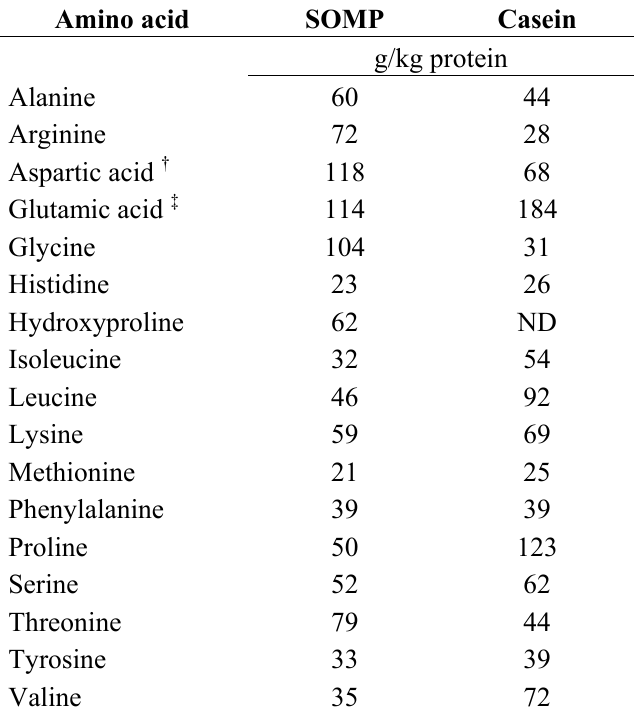
Table 3. Amino acid composition of